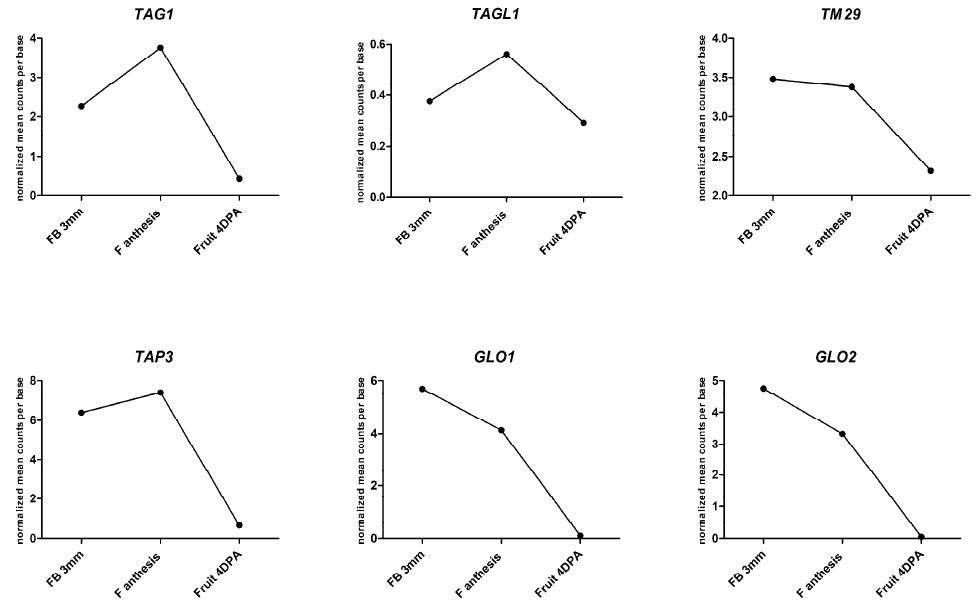
Figure 1. Expression level of TAG1 , TAGL1 , TM29 , TAP3 , GLO1 , and GLO2 genes in 3 mm-long flower buds (FB 3 mm), flowers at anthesis (F anthesis) and fruit at 4 days after anthesis (Fruit 4 dpa) of tomato Micro-Tom cultivar. Data obtained from the TomExpress database [101].